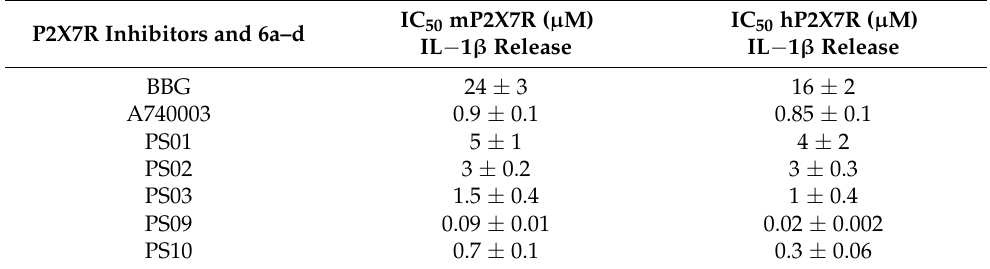
Table 1. P2X7 receptor antagonists and the selected sulfonamides inhibited ATP − induced IL − 1 β release. P2X7R Inhibitors and 6a–d